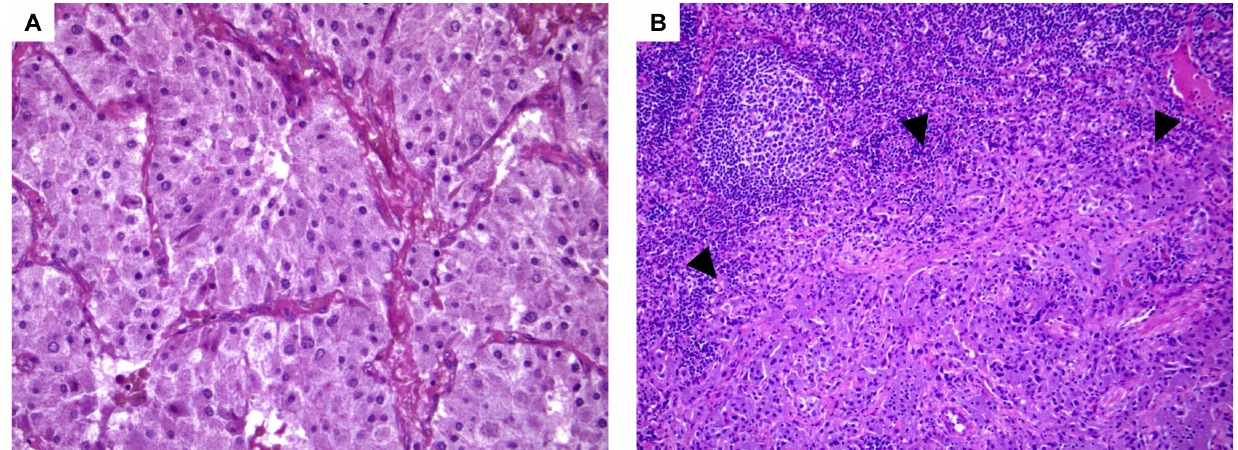
Figure 2. Histologic examination. ( A ): Pheochromocytoma showing nested architecture around a rich vascular network (H&E, original magnification ×20). ( B ): Nodal metastasis from pheochromocytoma is indicated by arrowheads (H&E, original magnification ×10).